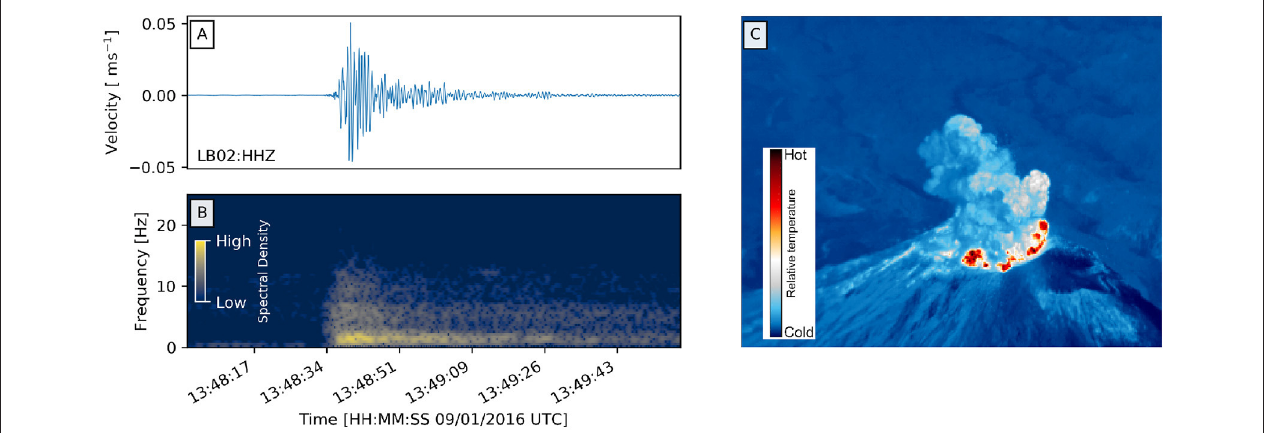
FIGURE 5 | Seismic record (A) and frequency spectrogram (B) of a small explosion recorded on 09/01/2016 at station LB02. A 0.1 Hz high-pass filter has been applied to the seismic record. (C) Thermal image of the explosion event captured at 09/01/2016 13:48:49.456 (UTC), 16 s after the explosion plume first appeared at the surface. For scale, the plume is over 300 m in height above the surface of the vent.